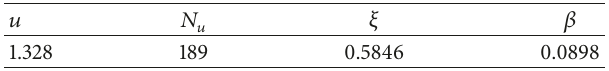
Table 5: Estimates of the parameters of the standard residual sequence for the GPD